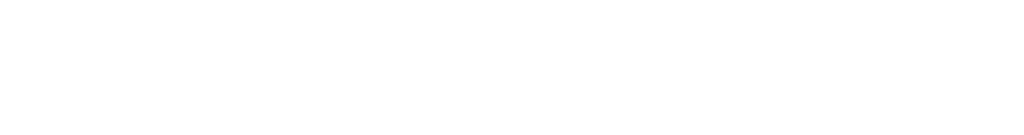
Logopediese Vereniging, Vol. 17, Nr. 1: Des.